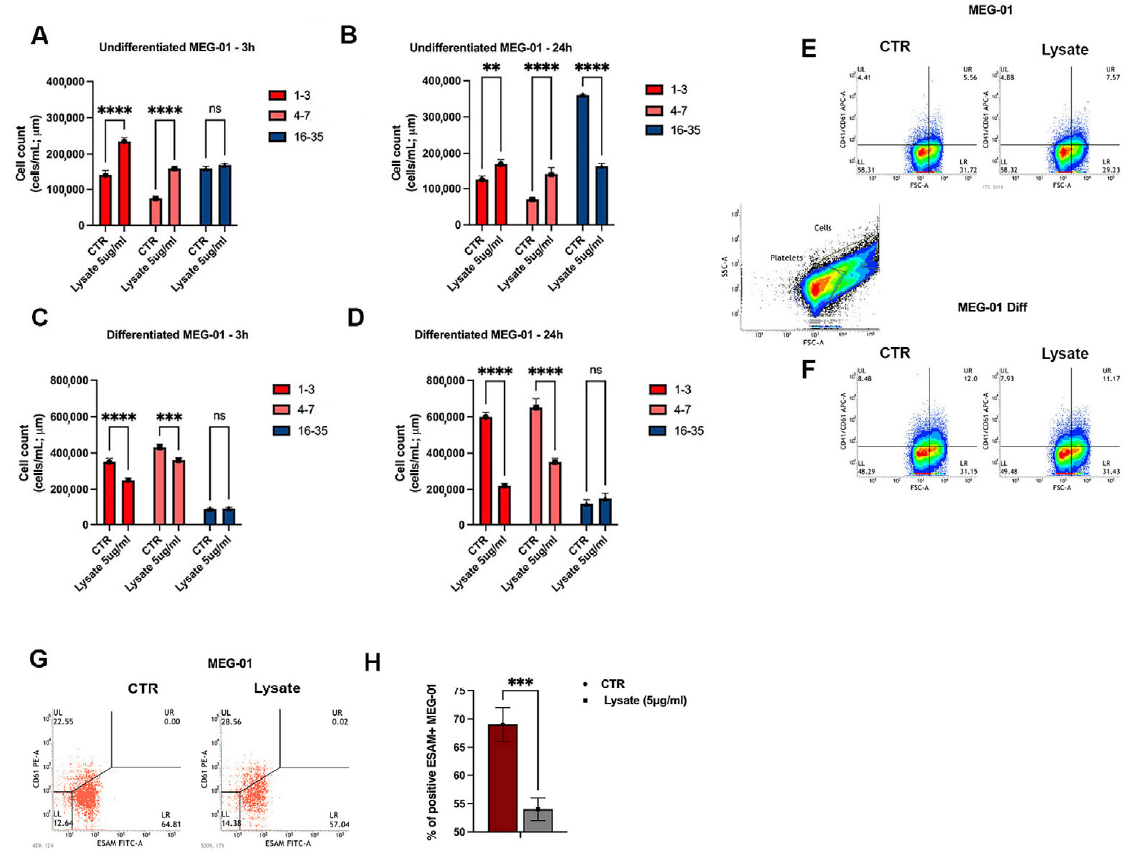
Figure 1. SARS-CoV-2 lysate effect on platelet-like particles and megakaryocytes in undifferentiated and differentiated MEG-01. ( A – D ) The histograms show the effect of inactivated SARS-CoV-2 lysate (5 µ g/mL) compared to those of control lysate (CTR) on undifferentiated ( A , B ) and differentiated MEG-01 (obtained upon 72 h treatment with thrombopoietin TPO 100 ng/mL and phorbol 12- myristate 13-acetate PMA 5 nM); ( C , D ) exposed to virus lysate for 3 h and 24 h, considering three subpopulations, discriminated by using an automized cell counter: red bars represent terminally differentiated platelet-like particles (Ø 1–3 µ m), pink bars shows larger and immature platelet-like particles (Ø 4–7 µ m), and blue bars represent proper megakaryocytes (Ø 16–35 µ m). While inactivated SARS-CoV-2 lysate (5 µ g/mL) induces the release of platelet-like particles in undifferentiated